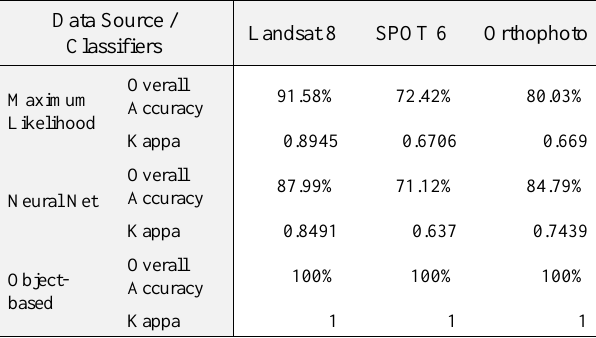
Table 6a. Confusion matrix for all classification result